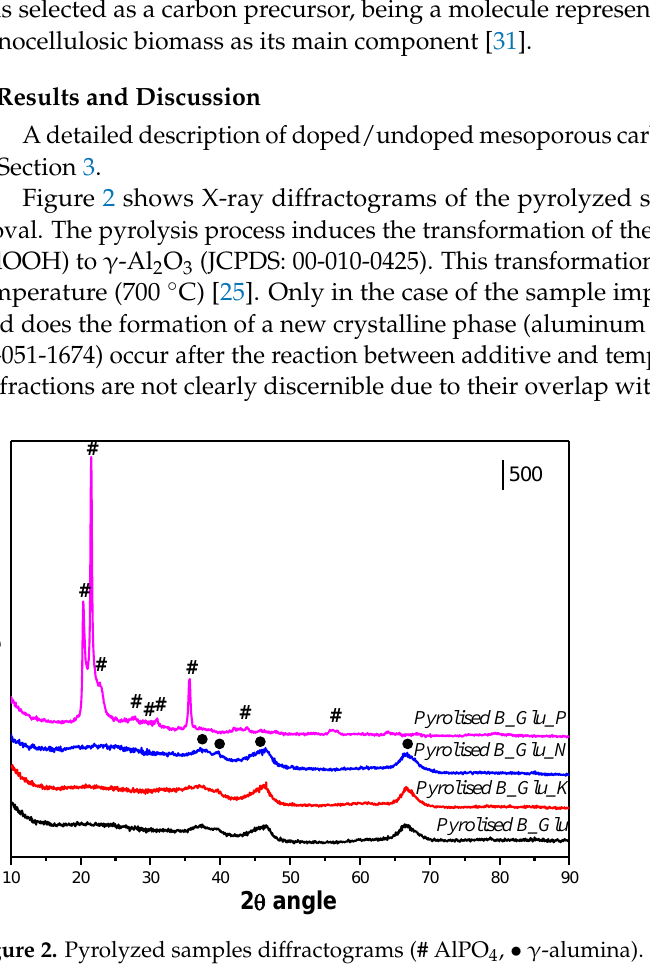
Figure 2. Pyrolyzed samples diffractograms ( # AlPO 4 , ● γ-alumina).